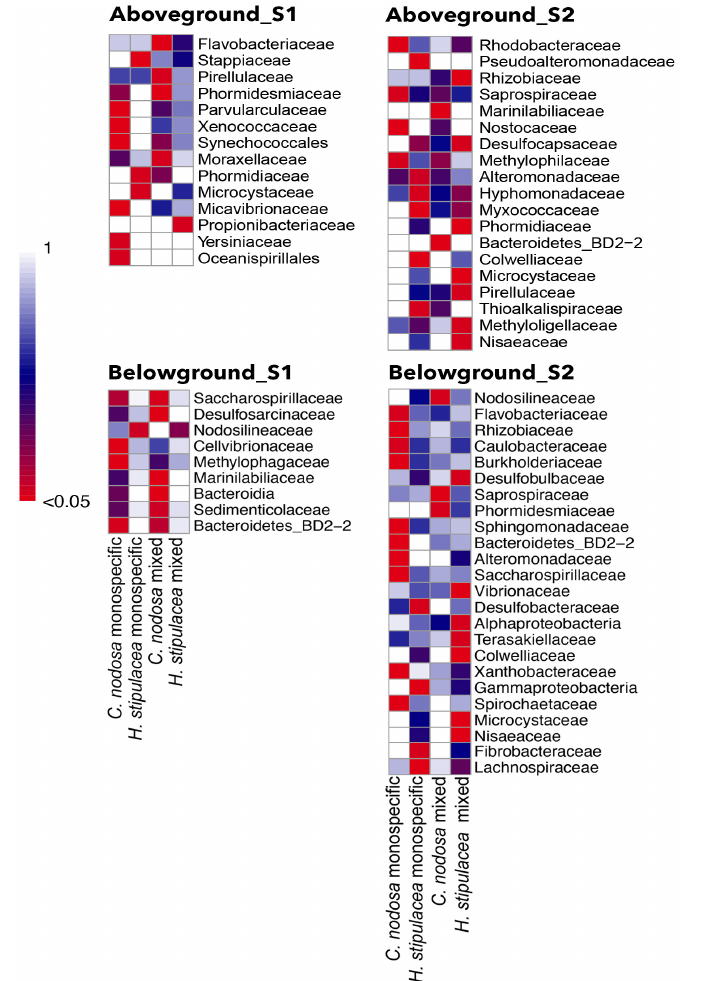
Figure 3. Heatmap visualization of the bacterial taxa significantly associated with the aboveground or belowground plant part using the Indicator Species Index (IndVal) in each site; significant p -value (<0.05) is reported in red.